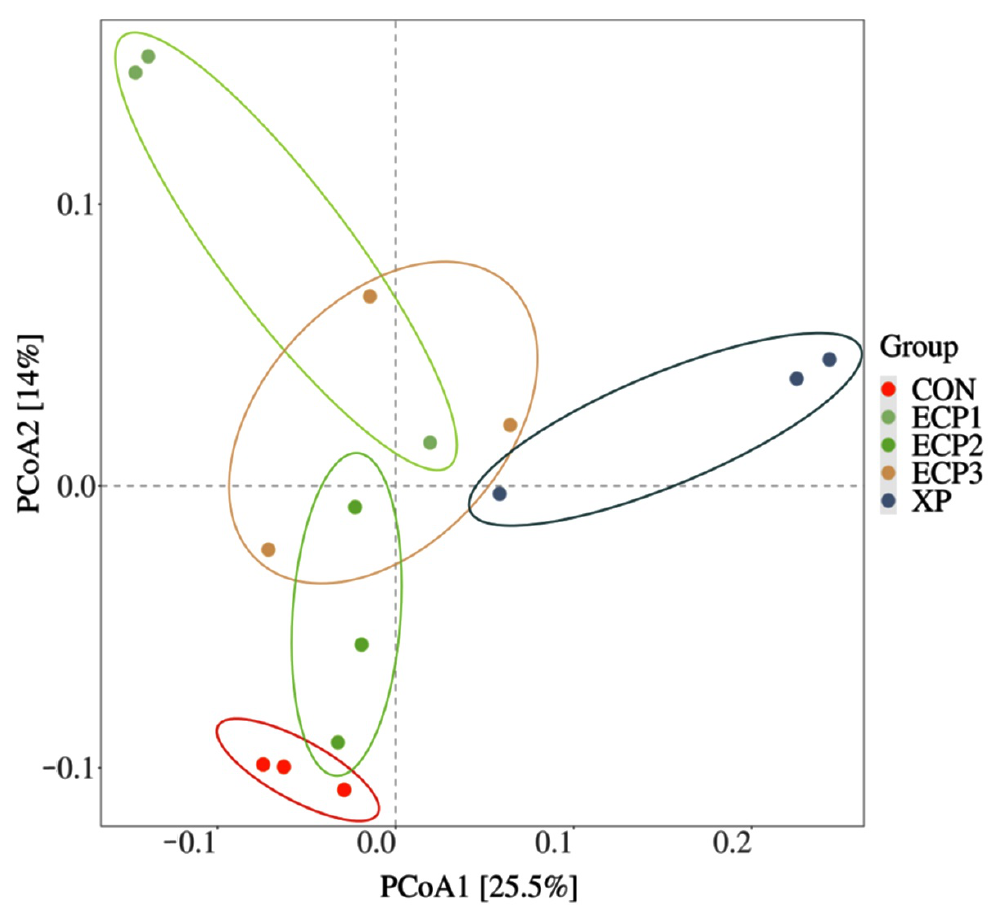
Figure 2. Bray–Curtis distance matrix PCoA of bacterial community in five treatments. CON treatment, without supplementation; XP treatment, XP yeast culture supplementation with 10 g/kg of substrate; ECP1, ECP supplementation with 6 g/kg of substrate, ECP2, ECP supplementation with 12 g/kg of substrate, ECP3, ECP supplementation with 18 g/kg of substrate.